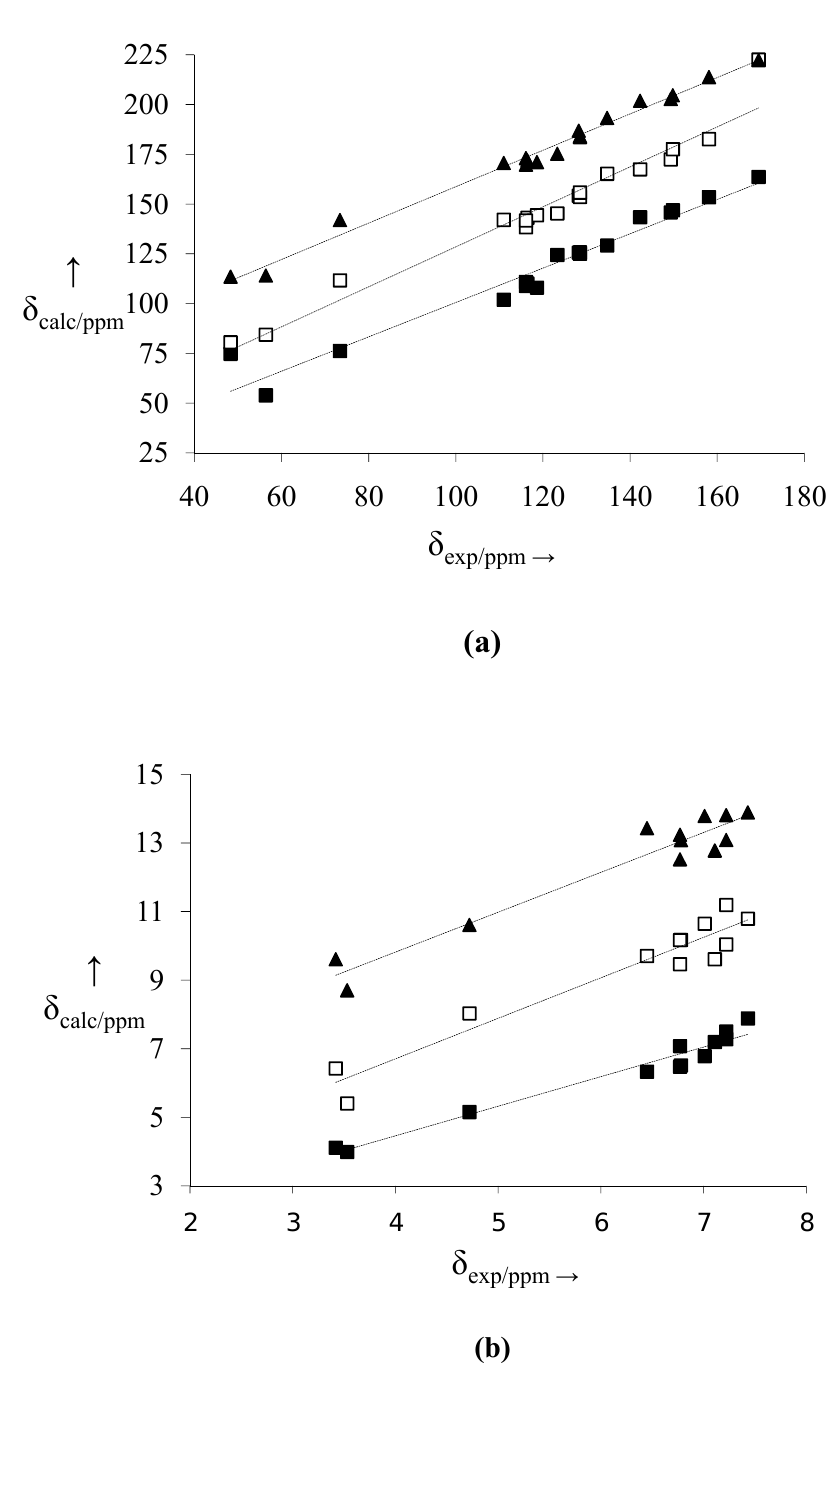
Figure 4. Correlation between experimental and calculated [B3LYP/6-31+G(d,p)] chemical shifts of 13 C ( a ) and 1 H ( b ) for structures O ( ■ ), S ( □ ) and N ( ▲ ). NMR data of the structures S and N were displaced from 30 to 60 ppm ( 13 C NMR) and from 3 to 6 ppm ( 1 H NMR), respectively. For each set of data the linear fitting is also reported as a dashed